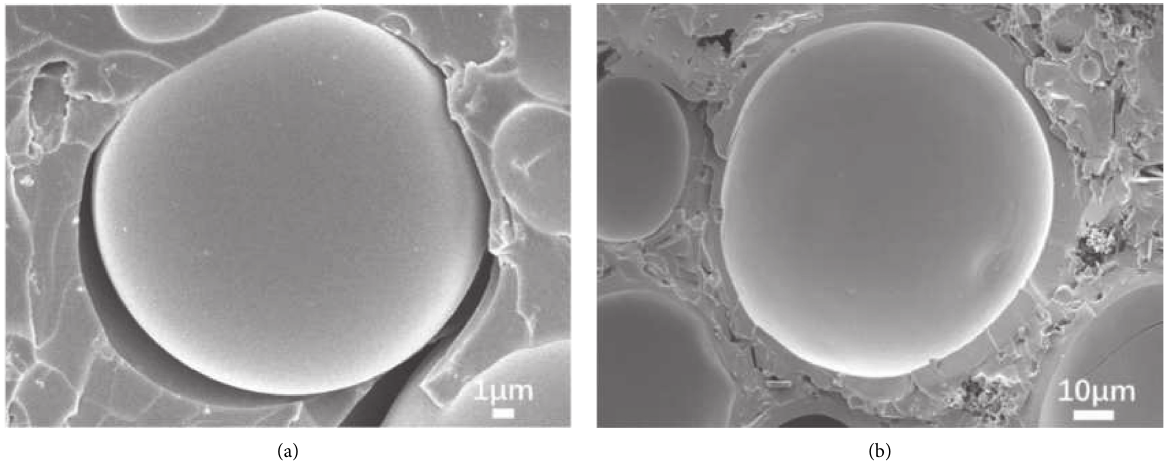
Figure 11: (a) SEM photograph of a single glass microsphere in HGM/phenolic syntactic foam and (b) SEM photo of a single phenolic microsphere in HPM/phenolic syntactic foam.